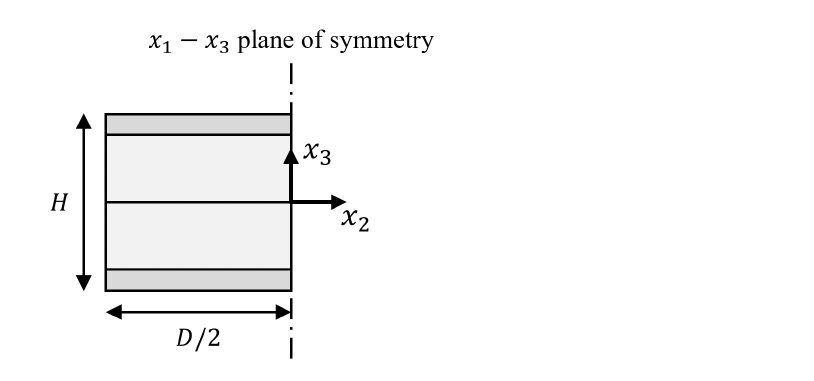
Figure 15. A simplified version of the canard cross-section (side-view). Table 2. The parameters of the X-core structure investigated in numerical example 2.